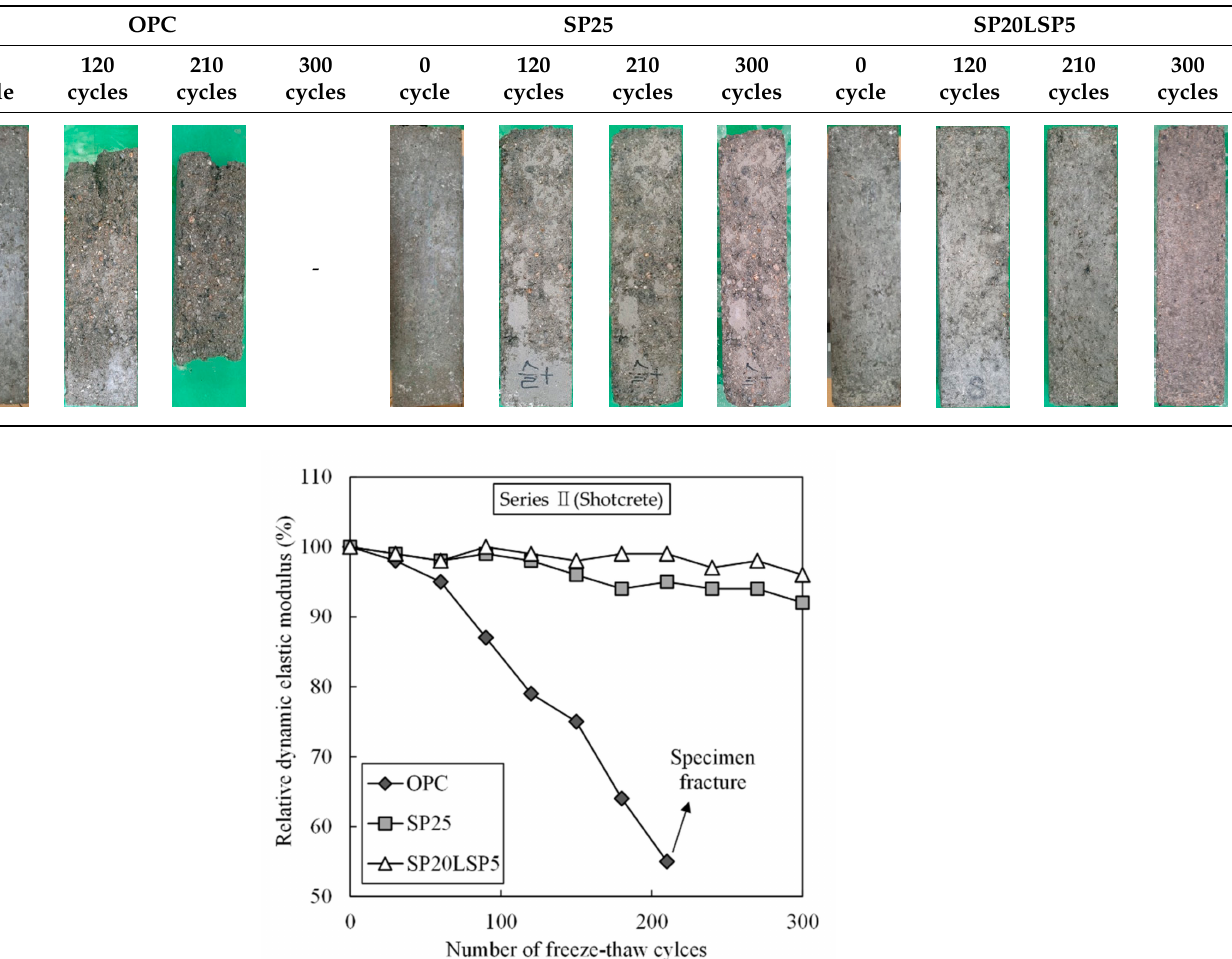
Figure 8. Chloride migration coefficient of shotcrete. Table 6. Surface scaling of shotcrete specimens exposed to freezing-thawing. Table 6. Surface scaling of shotcrete specimens exposed to freezing-thawing. Table 6. Surface scaling of shotcrete specimens exposed to freezing-thawing. Table 6. Surface scaling of shotcrete specimens exposed to freezing-thawing. Table 6. Surface scaling of shotcrete specimens exposed to freezing-thawing. Table 6. Surface scaling of shotcrete specimens exposed to freezing-thawing. Table 6. Surface scaling of shotcrete specimens exposed to freezing-thawing. Table 6. Surface scaling of shotcrete specimens exposed to freezing-thawing. Table 6. Surface scaling of shotcrete specimens exposed to freezing-thawing. Table 6. Surface scaling of shotcrete specimens exposed to freezing-thawing. Table 6. Surface scaling of shotcrete specimens exposed to freezing-thawing. Table 6. Surface scaling of shotcrete specimens exposed to freezing-thawing.